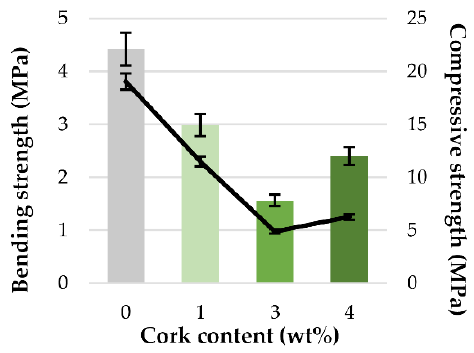
Figure 7. Mean failure strength from mechanical testing of mortars containing increasing cork content: three-point bending (bar chart), compressive strength (black line). The error bars stand for standard deviation error.